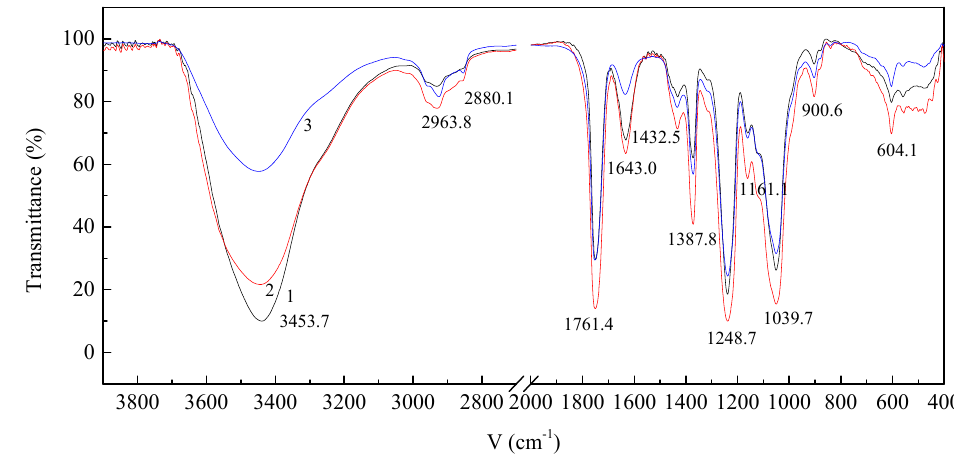
Figure 8. FT-IR spectra of diacetate fiber: (1) Untreated diacetate fiber; (2) Diacetate fiber treated by SCF-CO 2 at 80 °C, 20 MPa, 90 min; (3) Impregnation of diacetate fiber with resveratrol in SCF-CO 2 at 80 °C, 20 MPa, 90 min.